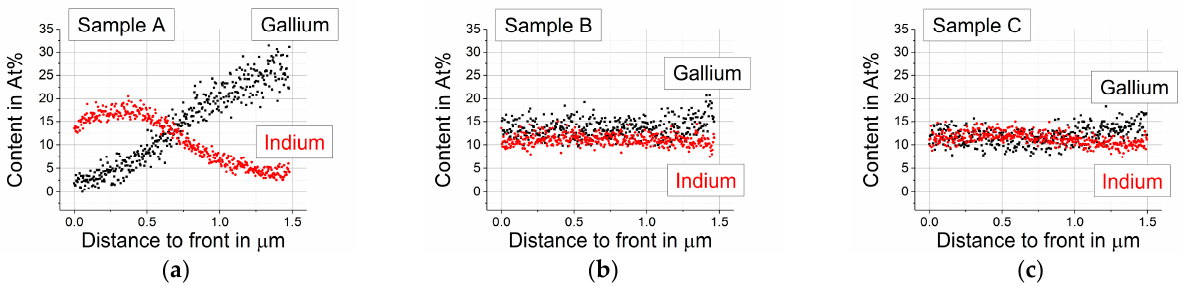
Figure 5. EDX line scans performed on the cross section at 20 keV: ( a ) sample A; ( b ) sample B; ( c ) sample C.